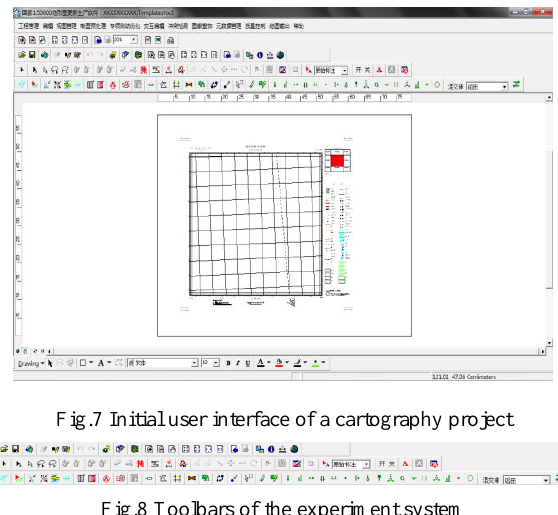
Fig.8 Toolbars of the experiment system